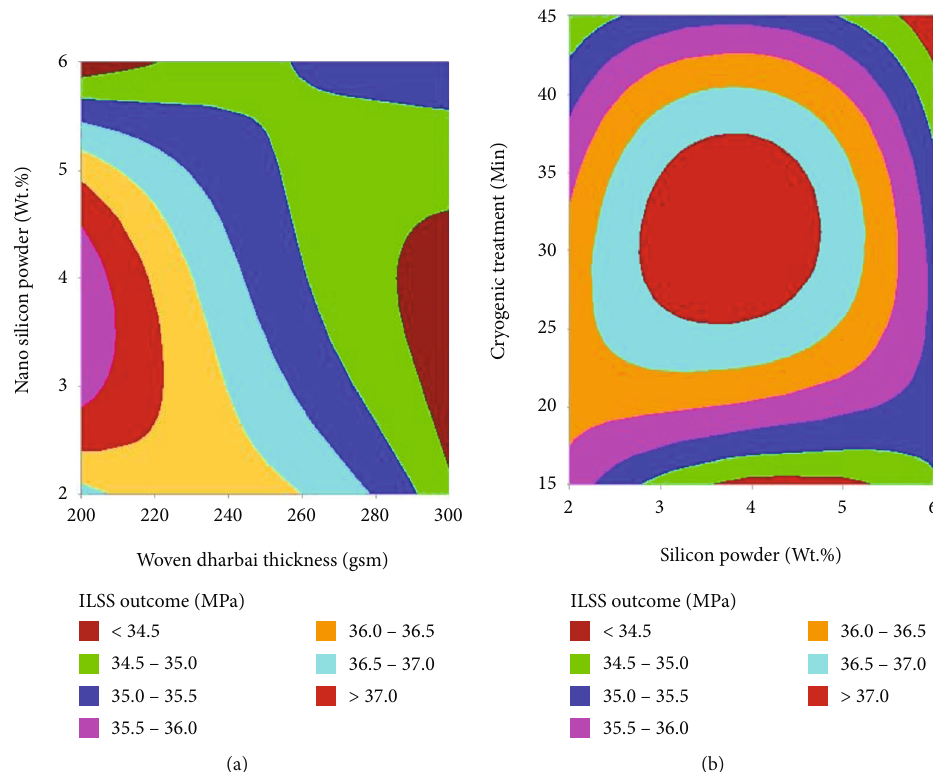
Figure 3: Contour plots of nanocomposites: (a) nanosilicon vs. Dharbai mat; (b) nanosilicon vs. cryogenic